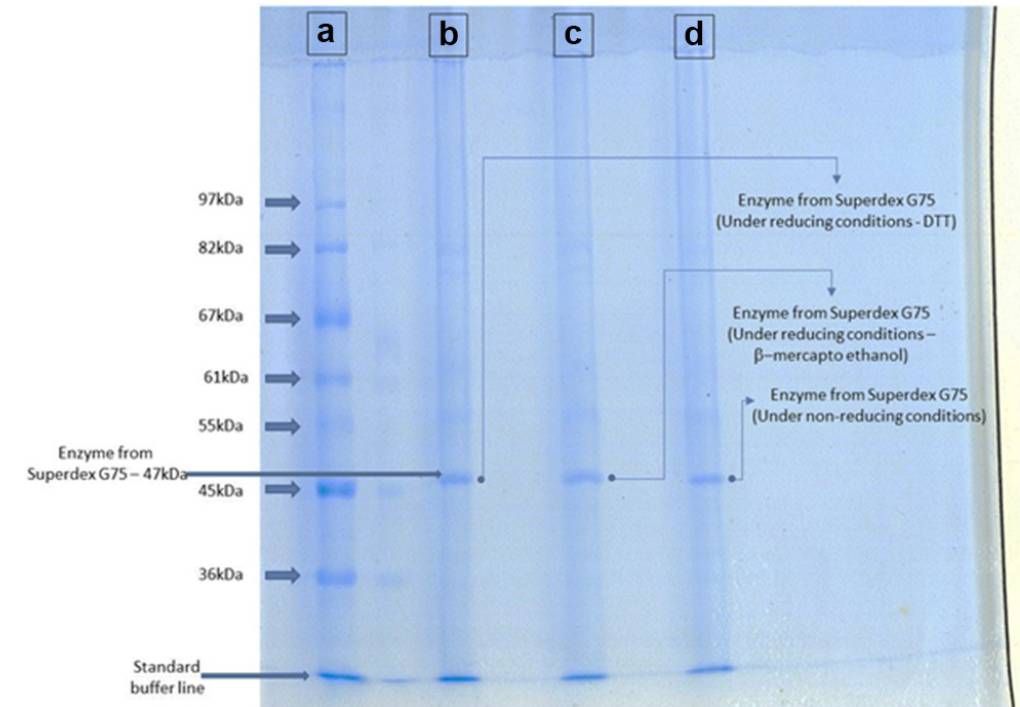
Figure 3. SDS-PAGE (10%) image of enzyme produced and purified from Aspergillus sydowii by FPLC system. (a) Molecular markers; (b) Enzyme purified under reducing conditions in presence of DTT; (c) Enzyme purified under reducing conditions in presence of b-mercapto ethanol; (d) Enzyme purified under non- reducing conditions. The standard proteins (×) used to calculate the linear regression: ribonuclease A (13.7kDa), carbonic anhydrase (29kDa), ovalbumin (43kDa), conalbumin (75kDa), aldolase (158kDa), ferritin (440kDa), and thyroglobulin (669kDa). The molecular mass of purified enzyme was calculated from the standard curve.